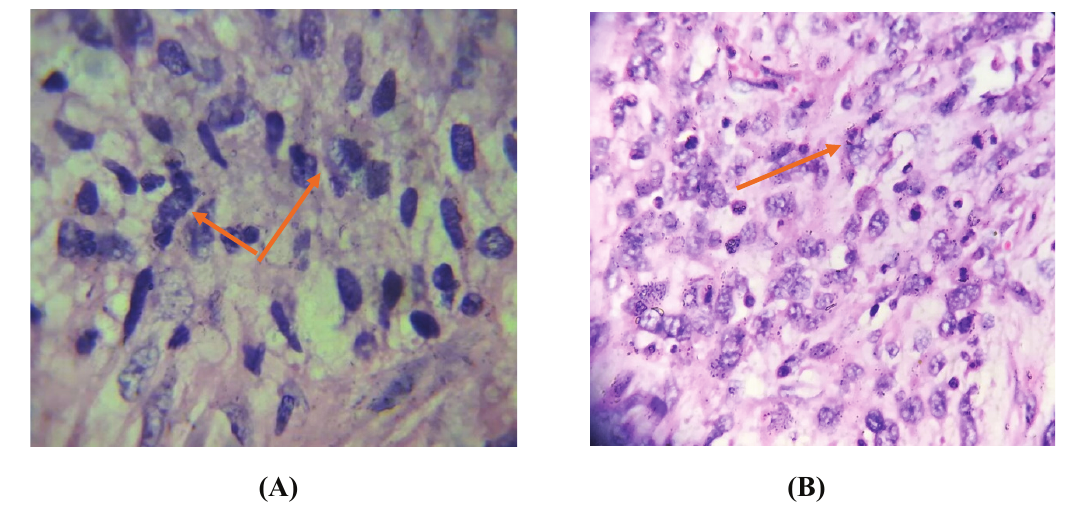
Figure 1: Malignant hypercellular sacromatous tumor formed with long fascicle of fusiform spindle-shaped cells arranged in herringbone pattern—spindle-shaped nuclei with scanty cytoplasm and indistinct borders (orange arrows)—Hematoxylin-eosin stain; magnification x 40 (A), magnification x 100 (B). The copyright of the image is kept for the authors.